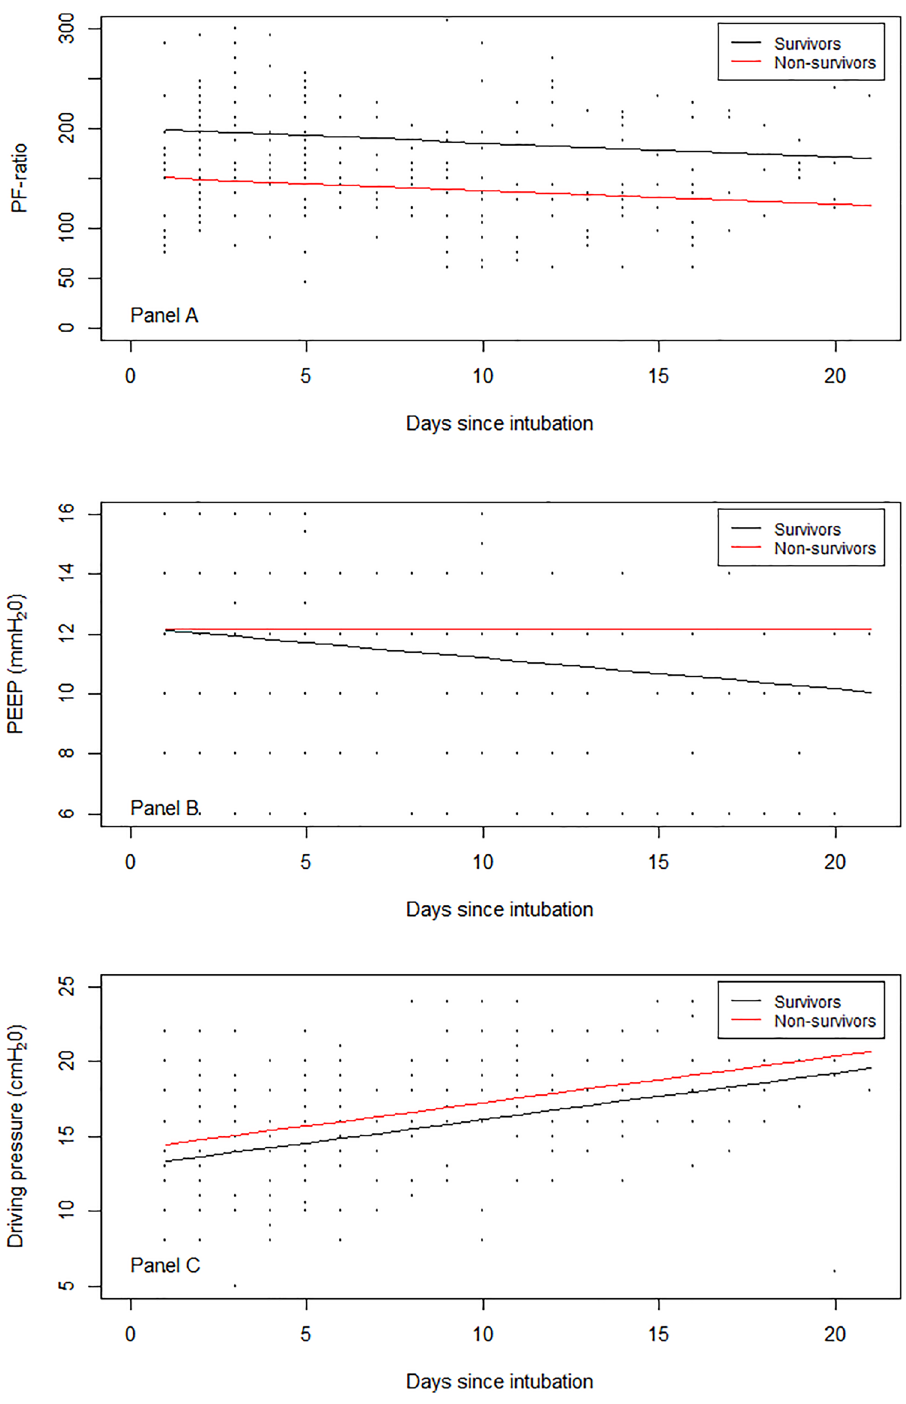
Figure 2. PaO 2 /FiO 2 -ratio (mmHg) and PEEP (cmH 2 O) for survivors and non-survivors over time. ( A ): PaO 2 / FiO 2 -ratio for survivors (black) and non-survivors (red) over time; ( B ): positive end-expiratory pressure (PEEP) for survivors and non-survivors over time; ( C ): driving pressure for survivors and non-survivors over